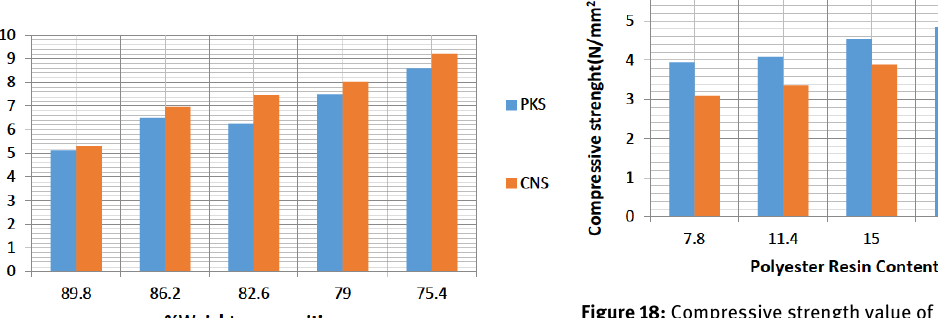
Figure 18: Compressive strength value of PKS & CNS for 420 µ